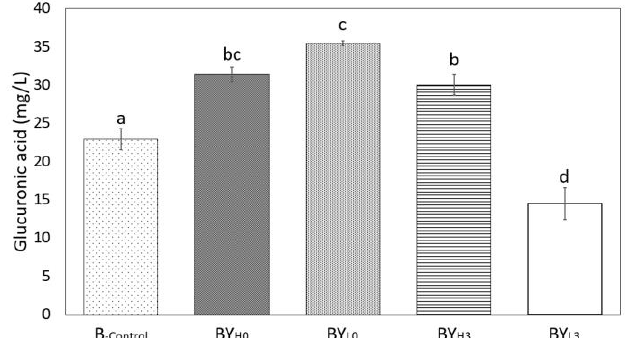
Figure 6. Glucuronic acid concentration after 14 days of cultivation using K. intermedius mono- (B - control ) and co-cultures with D. bruxellensis at 30 ◦ C. D. bruxellensis was added simultaneously at concentrations of 10 6 CFU/mL (BY H0 ) and 10 3 CFU/mL (BY L0 ) and sequentially at 10 6 CFU/mL (BY H3 ) and 10 3 CFU/mL (BY L3 ). Means with different letters are significantly different ( p < 0.05).